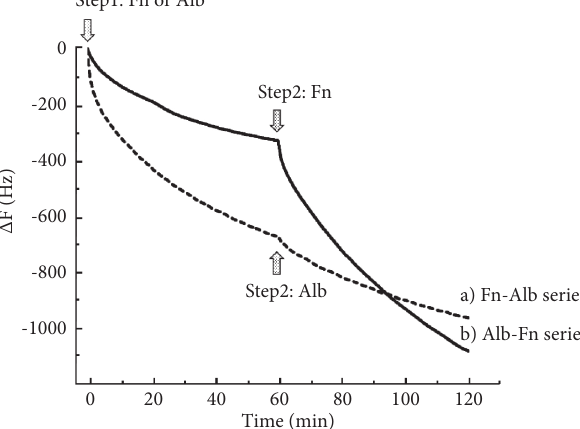
Figure 5: Δ F curves for Fn-Alb series and Alb-Fn series to ZrO